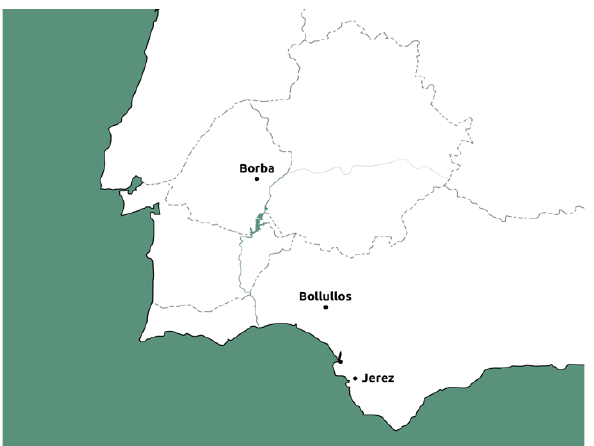
Figure 1. Case studies in the south-western Iberian Peninsula. (Rosado, 2020).